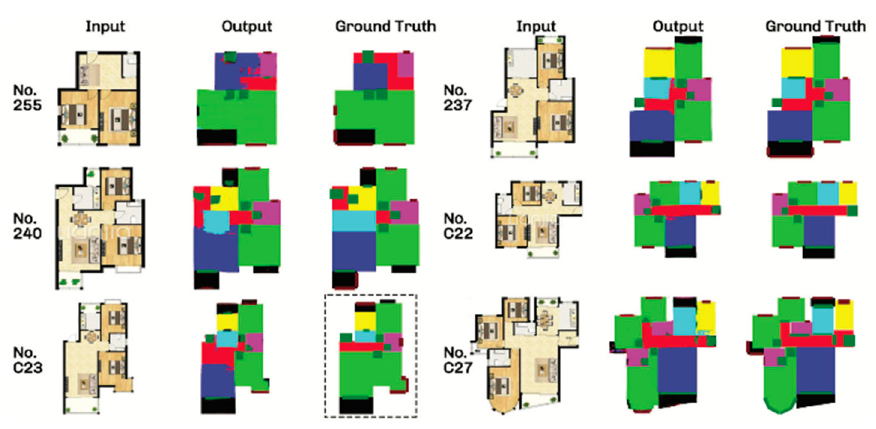
Figure 1. Floorplans training set